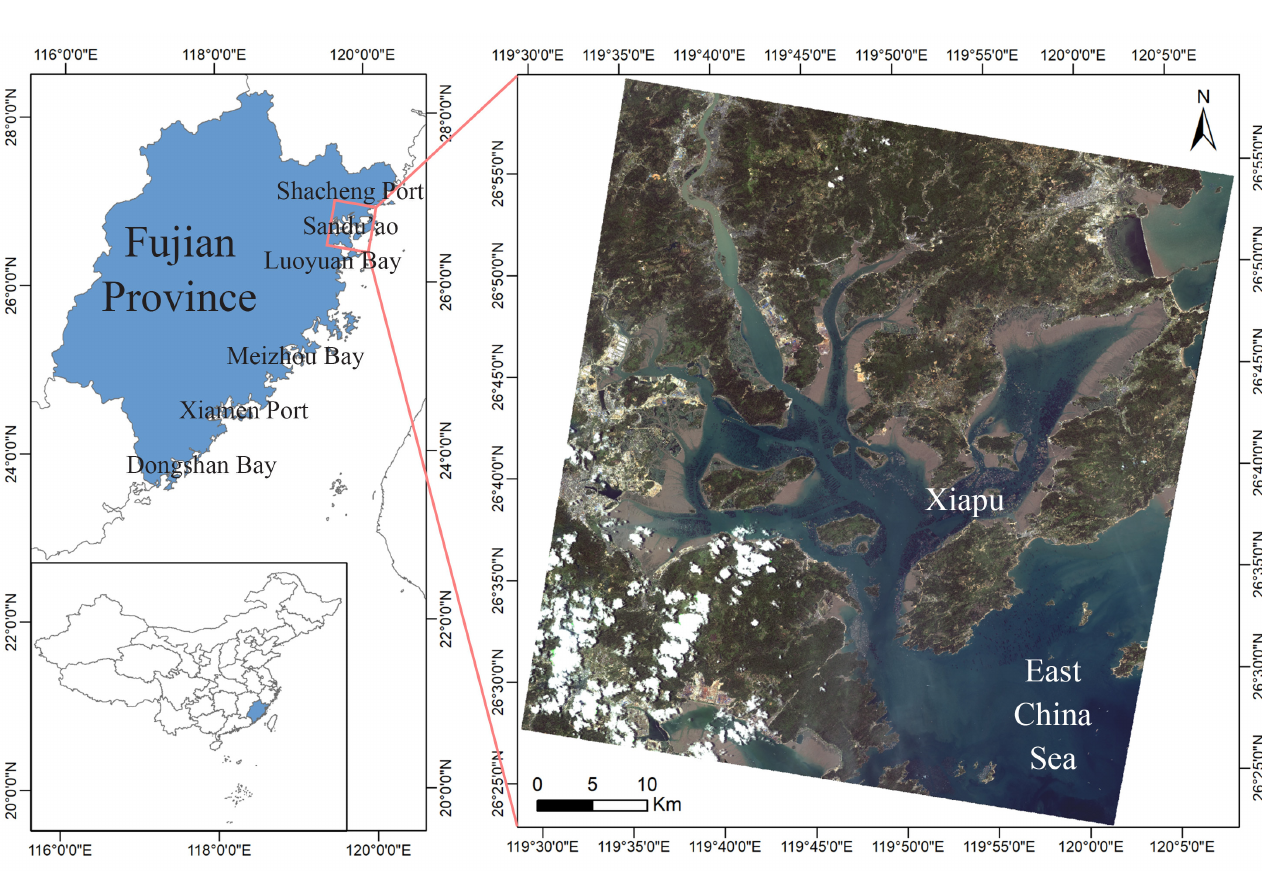
Figure 1. The location and range of Sandu’ao mariculture area in Fujian Province.